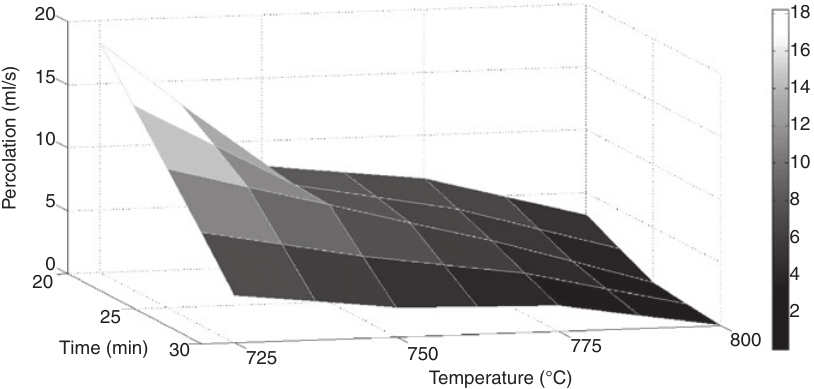
Figure 10: MG80 filter percolation as a function of sintering time and temperature.